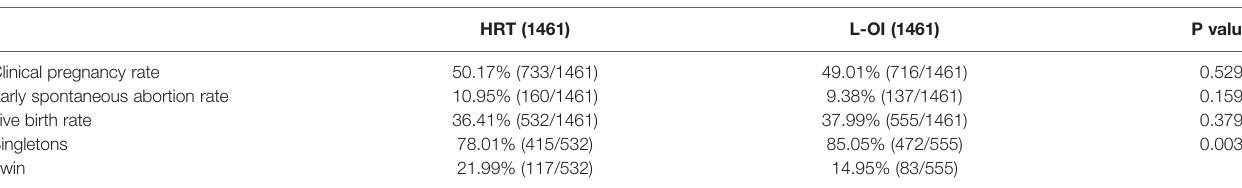
TABLE 4 | Clinical